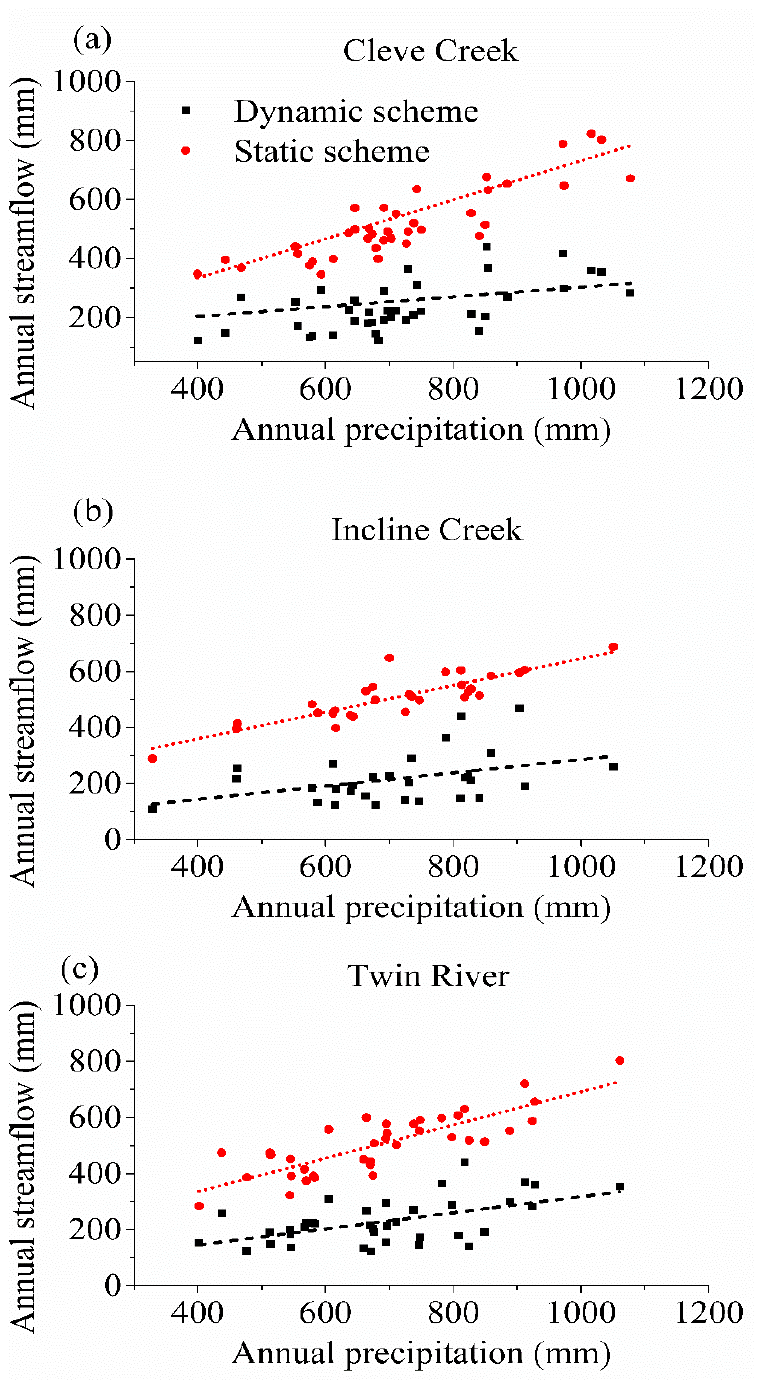
Figure 8. Comparison of precipitation-streamflow relationship for ( a ) Cleve Creek, ( b ) Incline Creek, and ( c ) Twin River watersheds between the static and dynamic scheme.